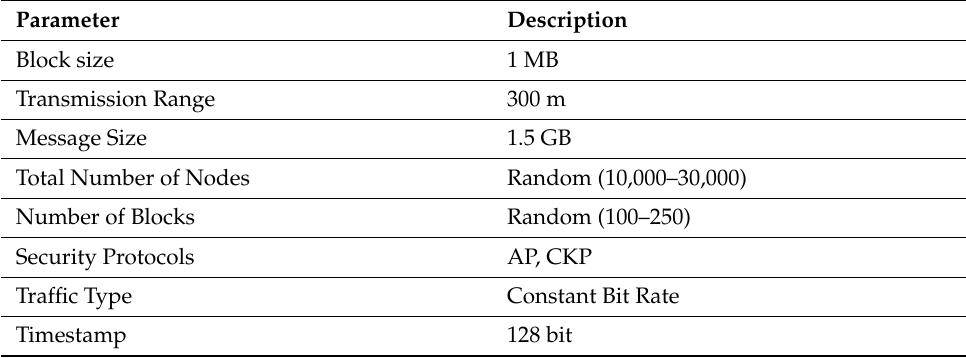
Table 1. Simulation